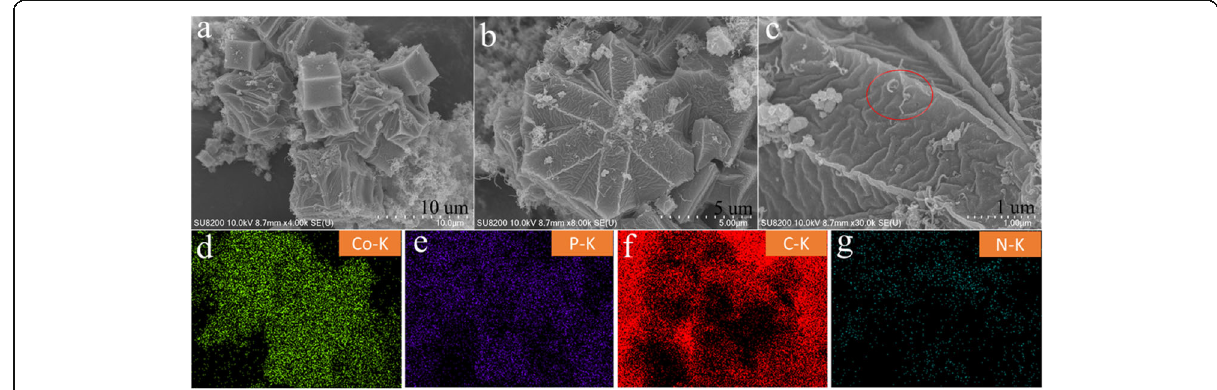
Fig. 9 SEM images of Co/P/MOFs-CNTs-700 ( a – c ) and the corresponding elemental mapping of Co ( d ), P ( e ), C ( f ), and N ( g ), respectively